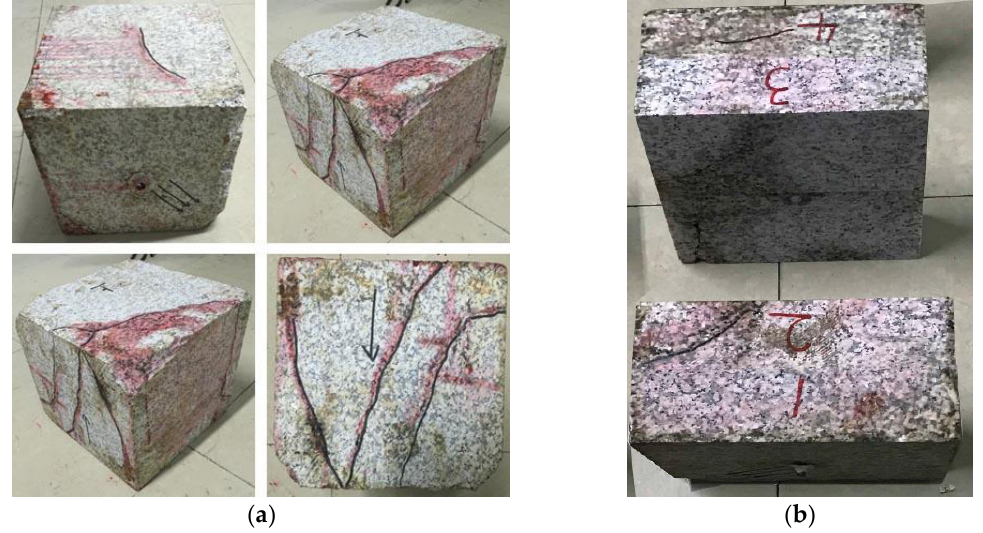
Figure 7. ( a ) The photo of the fractured rock sample, the black lines indicate fractures, red water flows out of the rock from these fractures and ( b ) the cut sample.